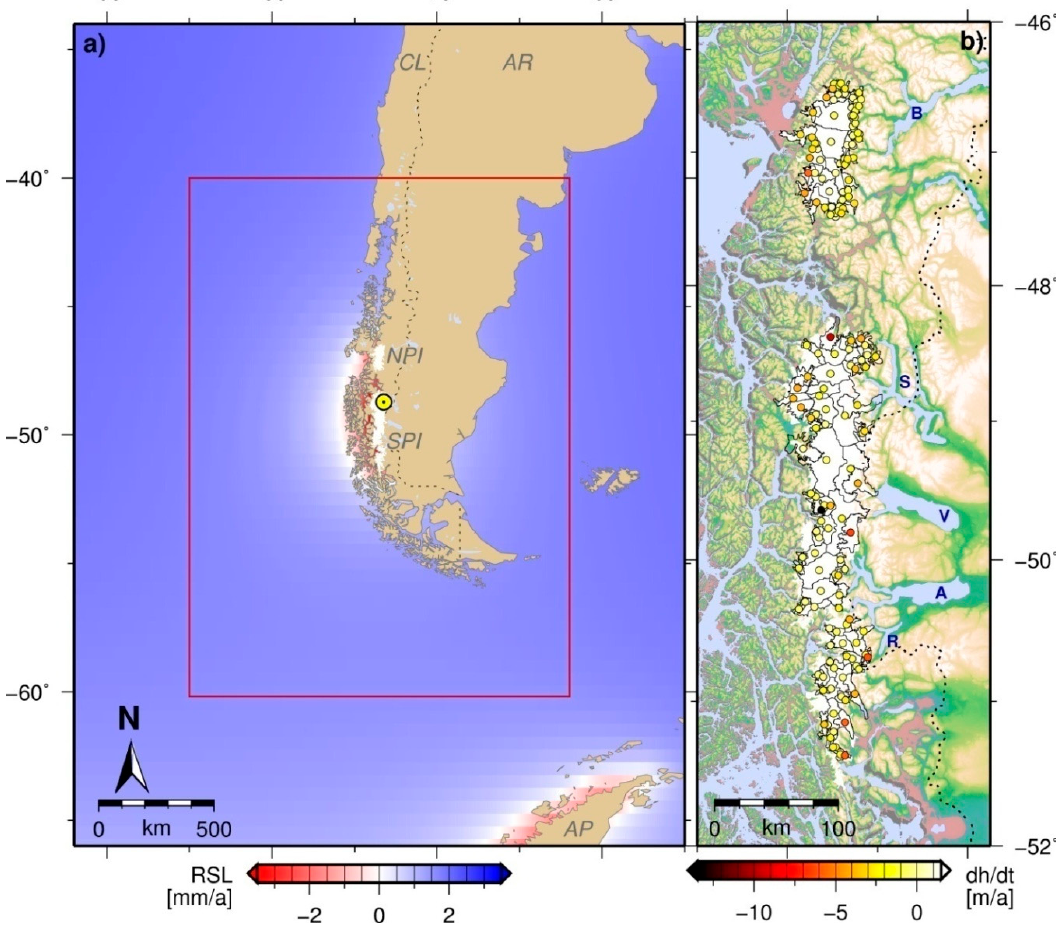
Figure 1. Maps of the region under investigation. ( a ) Location of the Northern (NPI) and Southern Patagonian Icefields (SPI) in southernmost South America. Color scale shows the ocean mass change rates contributing to the relative sea level according to our correction model (see text); yellow circle: data grid node for which time series are shown in Figure 2; red box indicates the extension of the grid used in the computations and corresponds to the map outline of Figure 3. AR—Argentina; CL—Chile; AP—Antarctic Peninsula. ( b ) Detailed map of the NPI and SPI area. Thin polygons on the icefields outline the accumulation and ablation zones of 87 glacier basins. Colored dots show the a-priori mass-rate pattern derived from ice elevation rates [2] at the barycenter coordinates for each zone. Lakes mentioned in the text: B—Lago Buenos Aires/General Carrera; S—Lago San Martín/O’Higgins; V—Lago Viedma; A—Lago Argentino; R—Brazo Rico and Brazo Sur. Southern Patagonia is characterized by a series of distinct Neoglacial advances and retreats during mid-to-late-Holocene times (0–5 ka before present) [10,11]. The most recent advance corresponds to the regional LIA. This history is inferred from datable moraine materials [11] and is